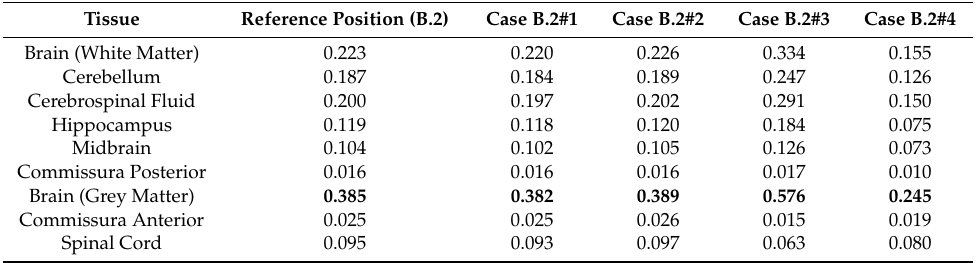
Table 5. Maximum values of E-field (V / m) for the CNS tissues. Influence of body position for posture B.2. The variation of the maximum E-field values reached in the Grey Matter is highlighted in bold character. Tissue Reference Position